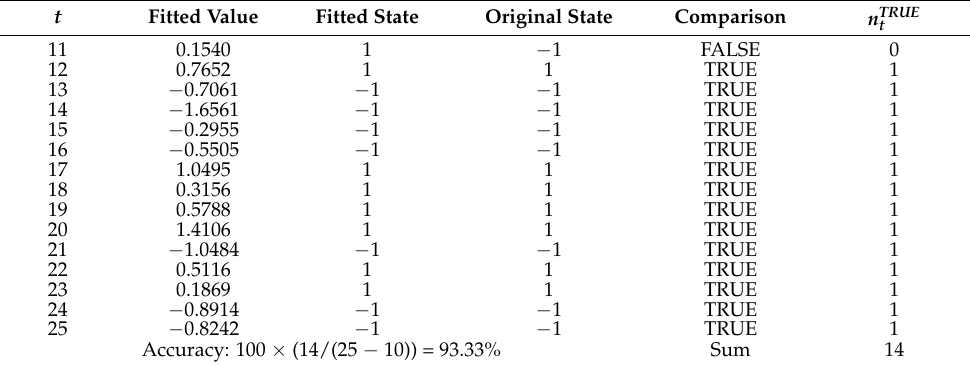
Table 23. Fi tt ed series with corresponding states, and model accuracy for M4 x –original displace- ments. Table 23. Fitted series with corresponding states, and model accuracy for M4 x –original